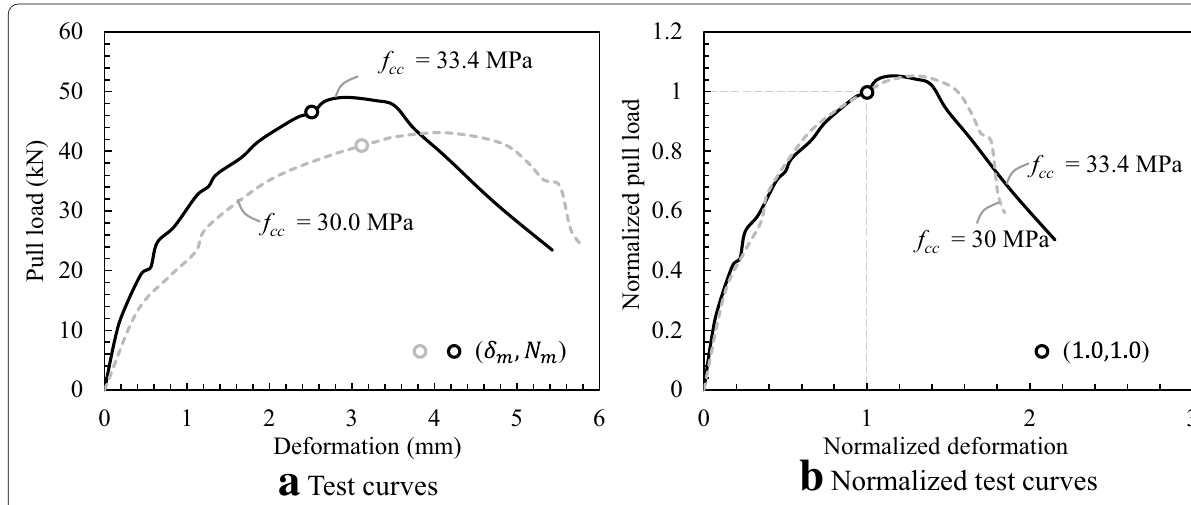
Fig. 14 Typical load–deformation curves of anchoring concrete with different concrete strengths.